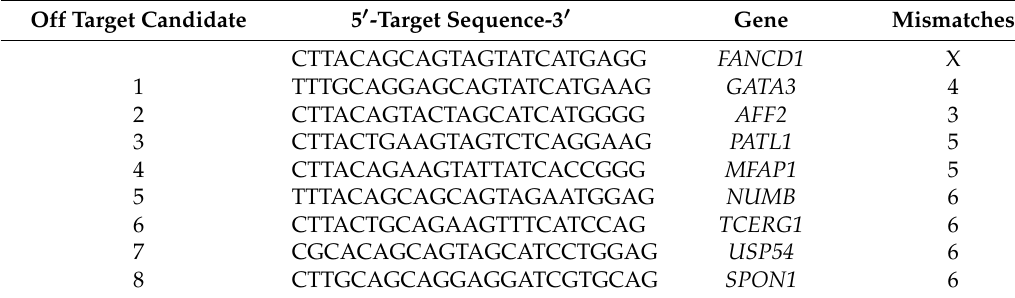
Table 1. Off target sites present in coding regions.